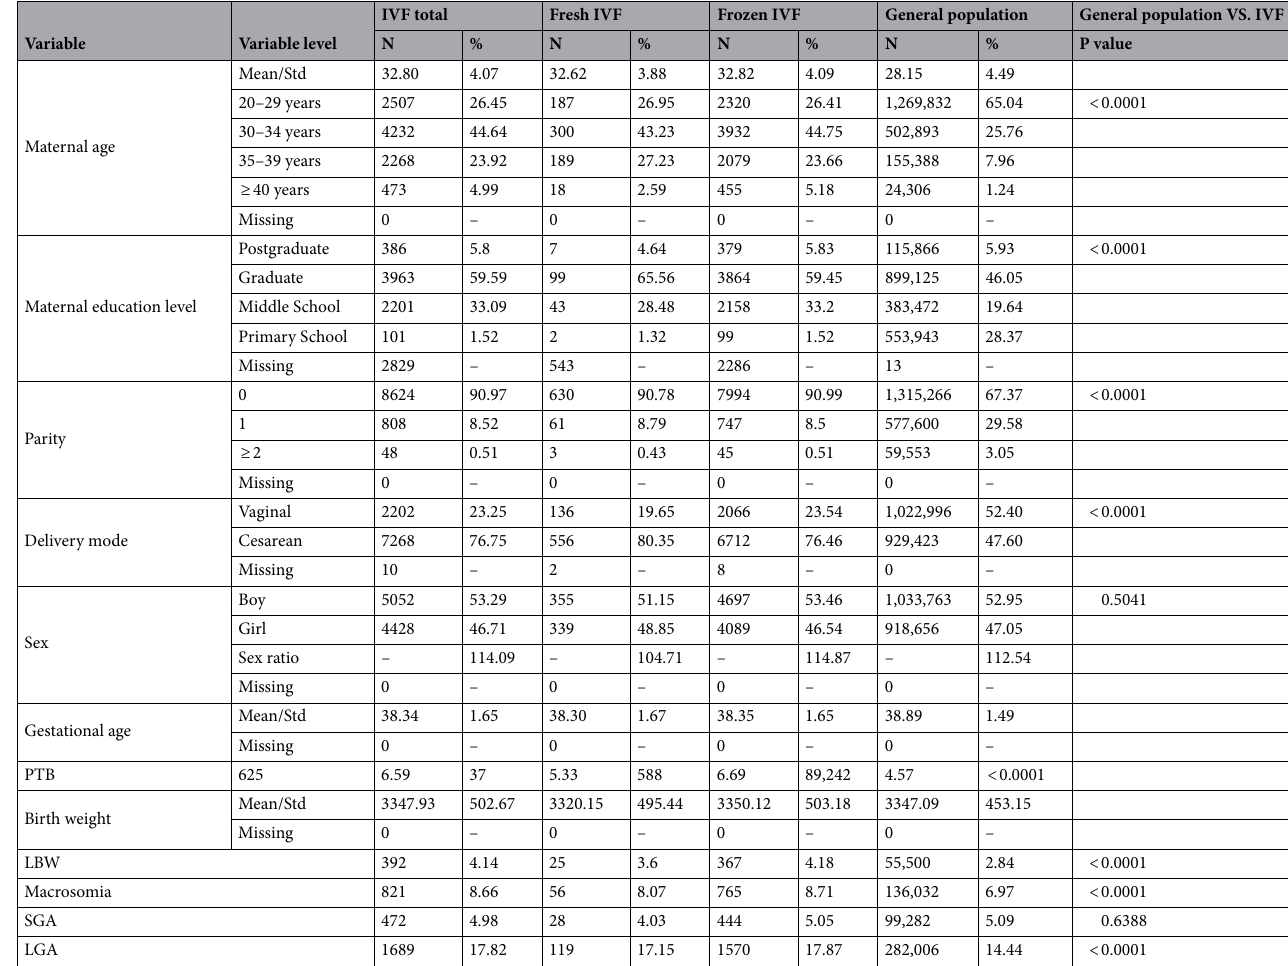
Table 1. Maternal and neonatal characteristics of IVF infants and general